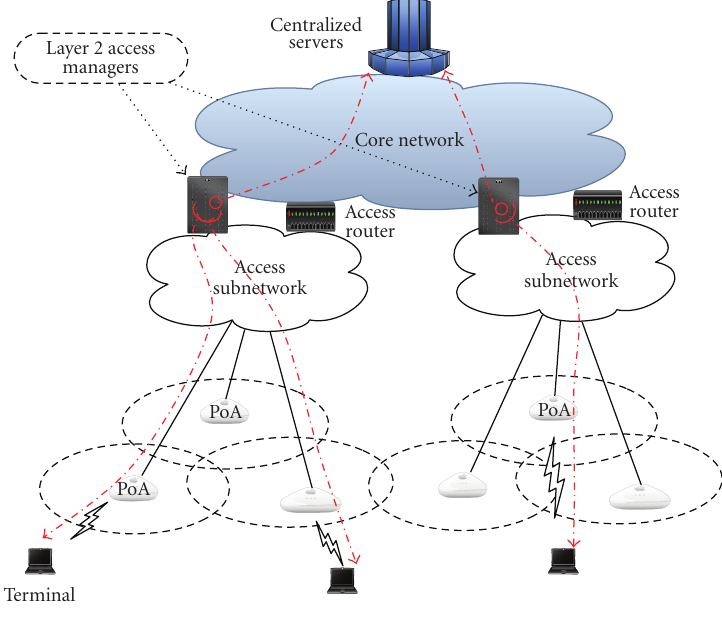
Figure 1: The L2-Acc-Mgr in the network